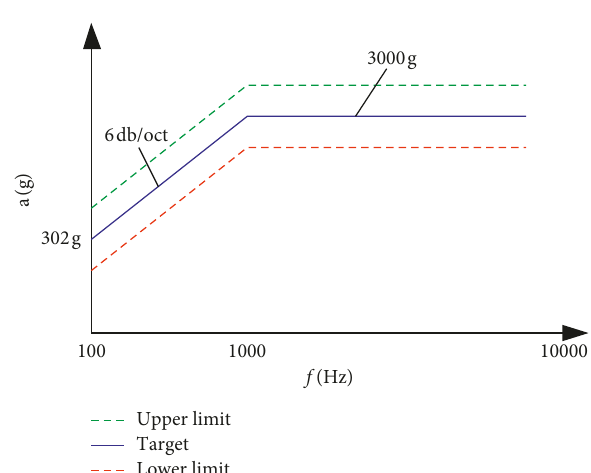
Figure 9: Test condition of the shock spectrum response